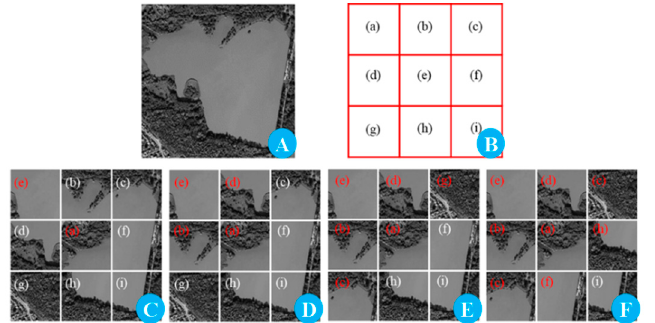
Figure 11. Spatial exchange of local area of remote sensing image. ( A ) Original image, ( B ) block grid, ( C ) exchange (a)–(e) sub-blocks in original image, ( D ) increase exchange (b)–(d) sub-blocks, ( E ) add exchange (c)–(g) sub-blocks, and ( F ) add exchange (h)–(f)